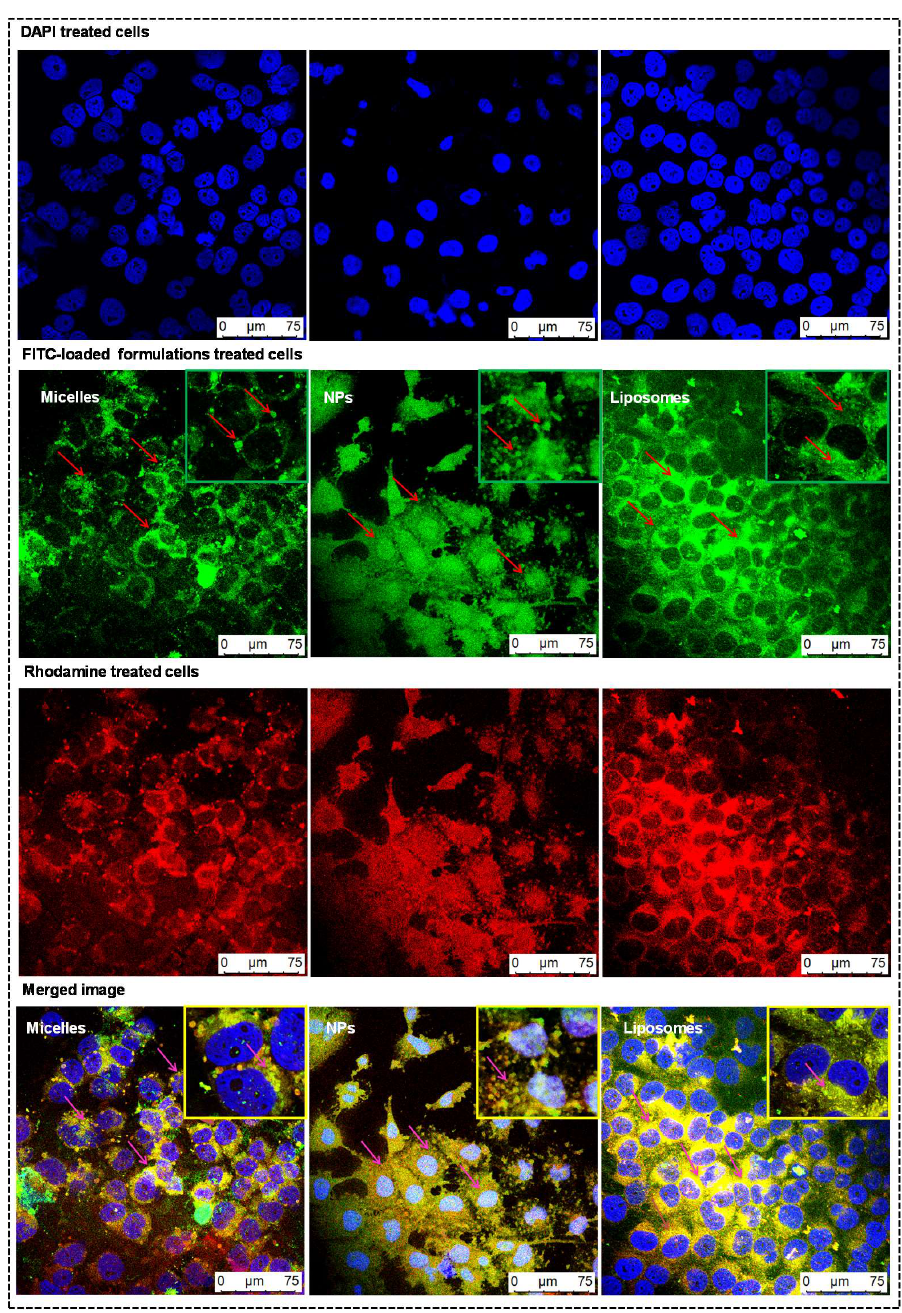
the yellow color intensity was more dominant in case of cells treated with FITC-loaded liposomes due to rapid internalization through cancer cell membranes.